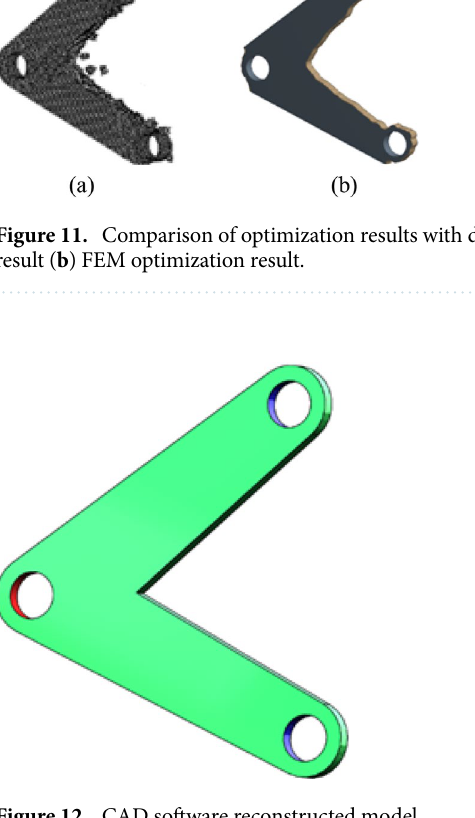
Figure 12. CAD software reconstructed